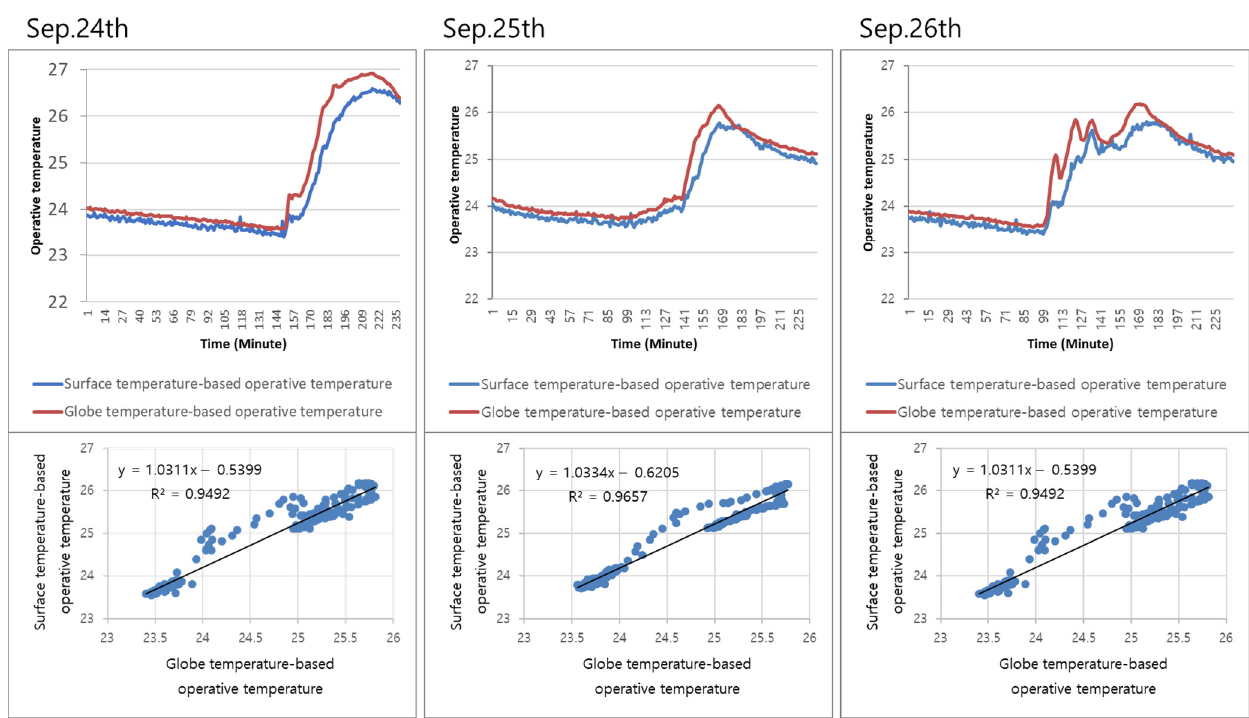
Figure 12. Regression analysis for mean radiant temperature (MRT) and mean surface temperature (MST).